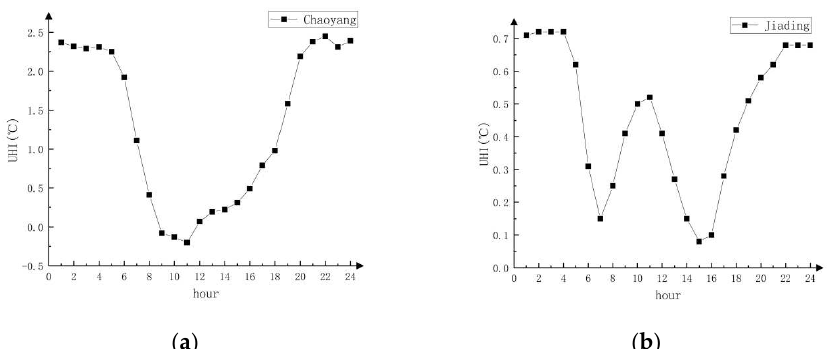
Figure 1. Average heat island intensity of Chaoyang ( a ) and Jiading ( b ).